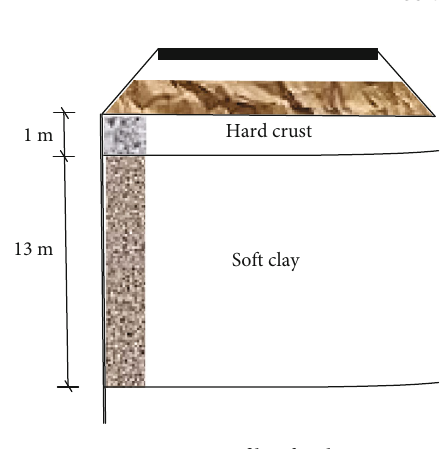
Figure 6: Pro fi le of